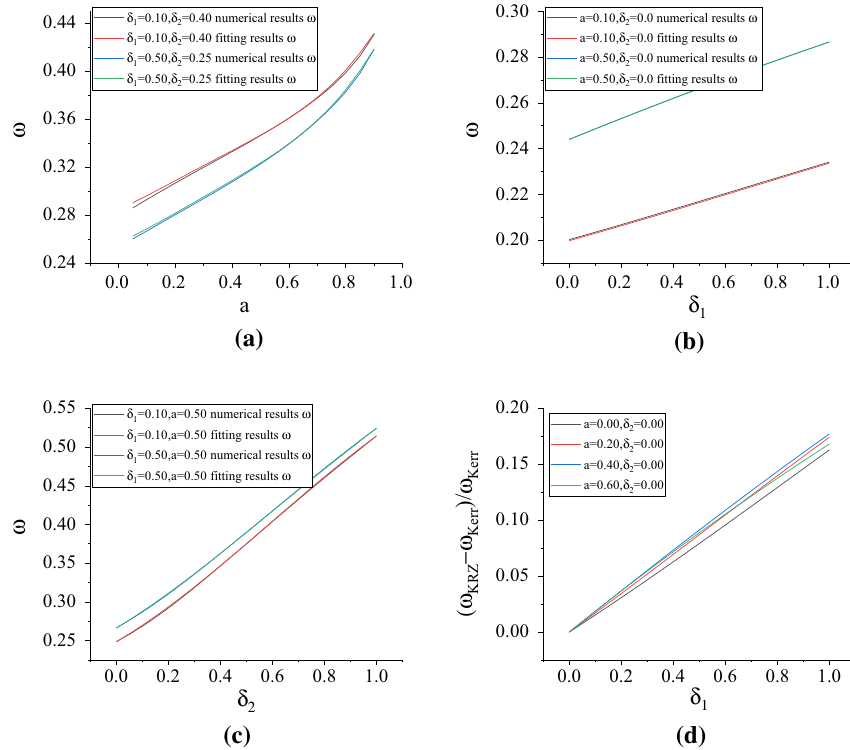
Fig. 2 Comparison of numerical and fitting results for the frequency depending on the spin a , δ 1 and δ 2 parameters. The corresponding parameters have been given in the figures. In all calculations we use the equatorial plane i.e. θ = π/ 2